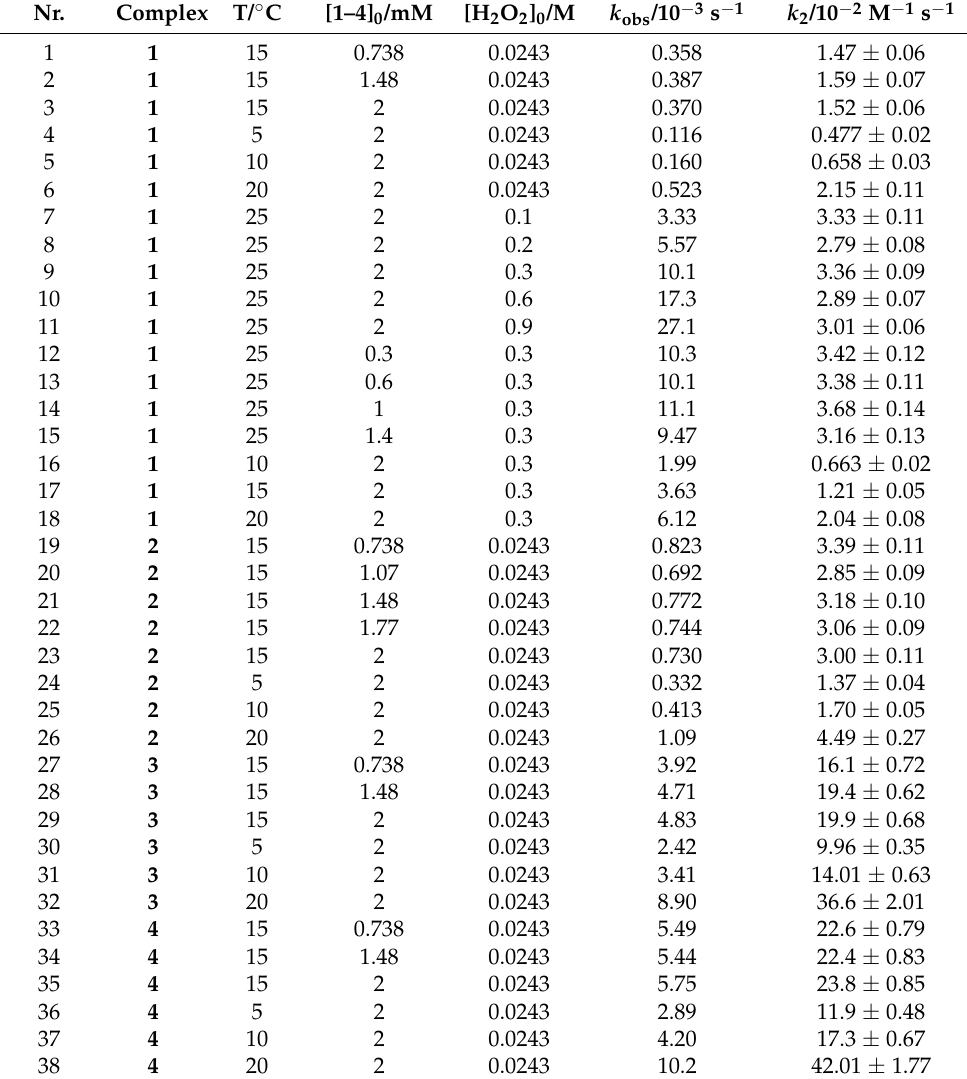
Table 3. Kinetic data for the disproportionation of H 2 O 2 mediated by 5 , 6 , 7 and 8 in CH 3